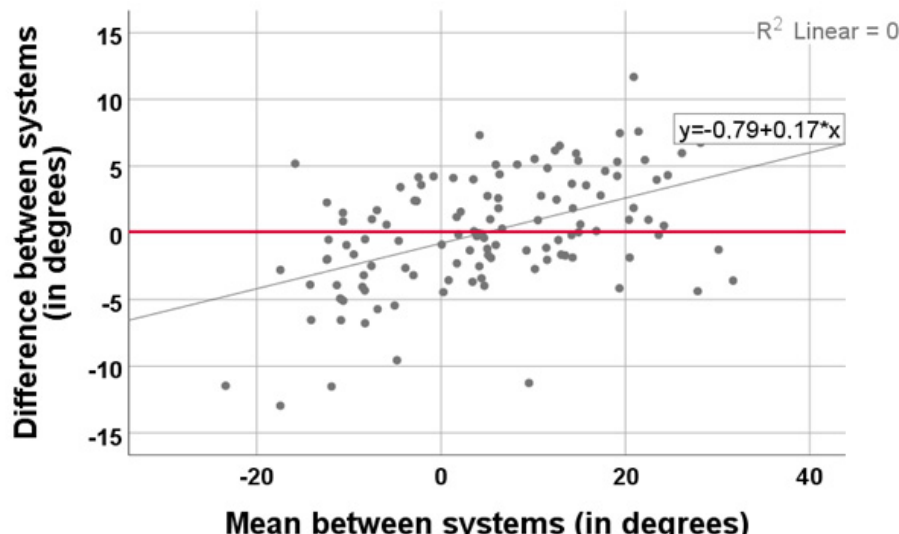
Figure 2. Scatterplot of mean FPA against the difference in FPA between the two systems of all gait types combined. Difference in FPA between IMUs (Opal sensors) and the PSW (Zeno™ Walkway) is displayed on the y–axis, and the mean FPA for Opal and Zeno™ is displayed on the x–axis. The red line represents the mean difference. A linear regression line ( y = − 0.79 + 0.17 ∗ x ) is fitted to the dots.